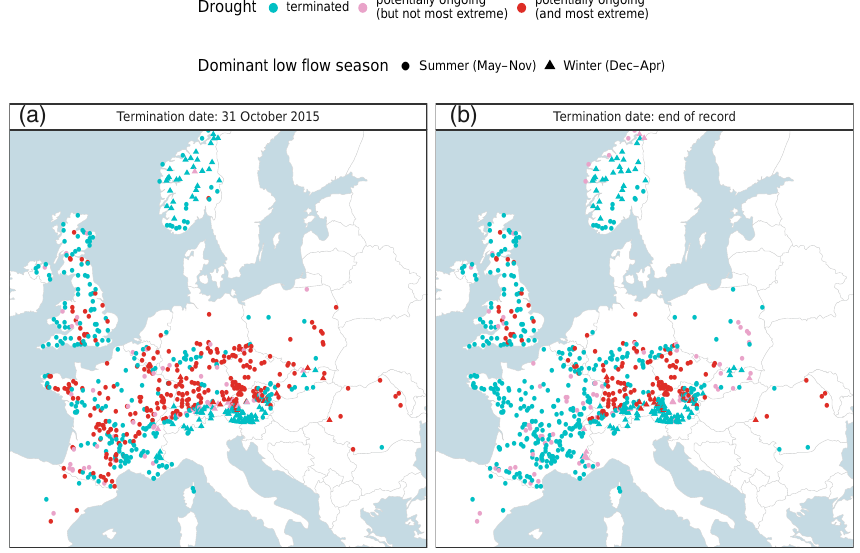
Figure 10. Stations potentially under drought (a) at common termination date 31 October 2015, and (b) at end of record (10 November 2015– 6 February 2016, variable between gauges). Red points indicate that the catchment has not totally recovered from the summer drought so that an event just after the end of record would be pooled by the SPA